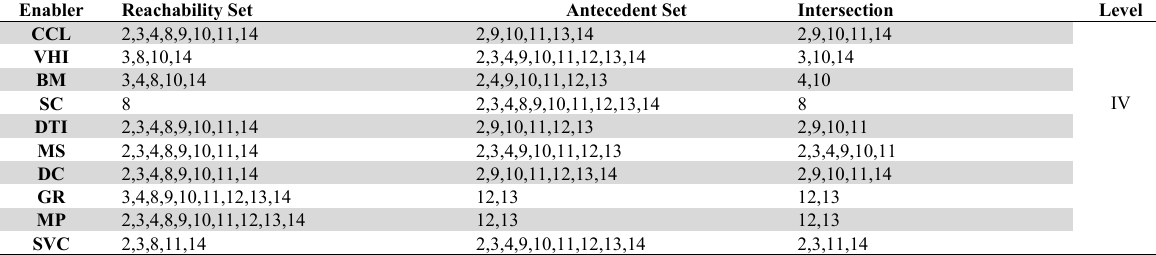
Level partitioning Iteration